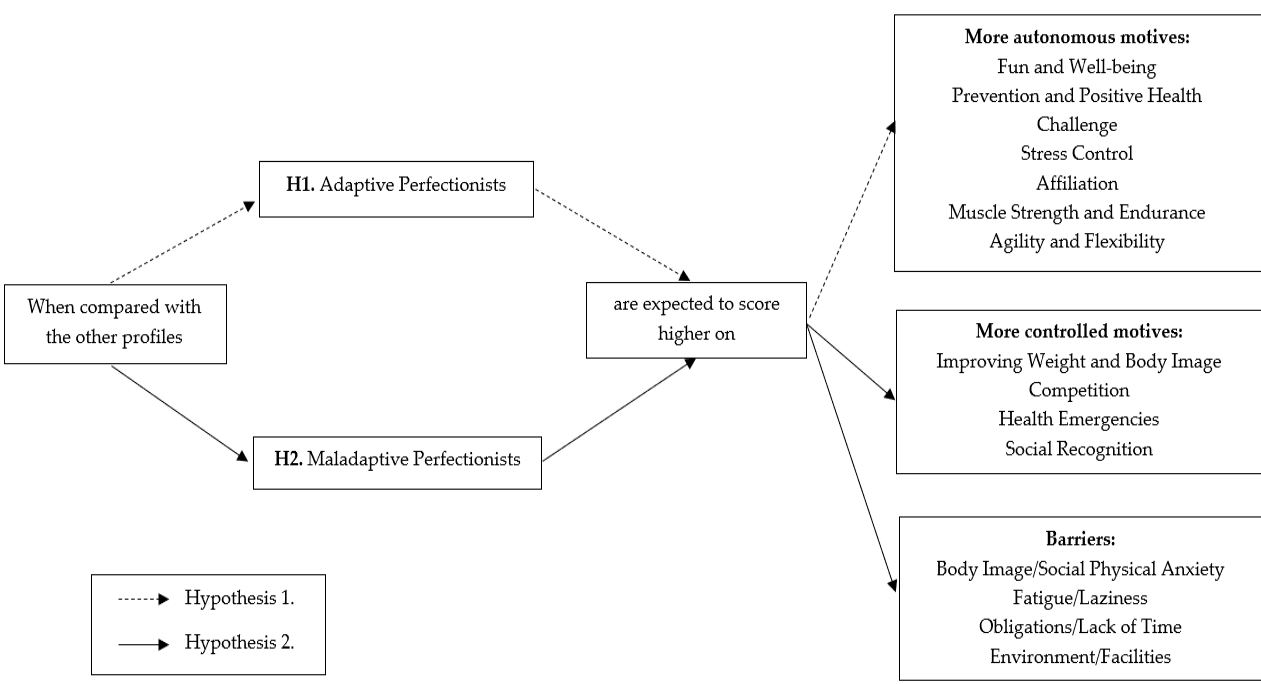
Figure 2. Schematic representation of the hypotheses.